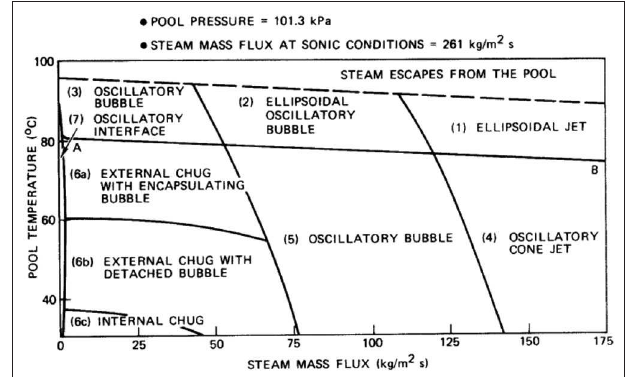
FIGURE 2 | The regime map developed by Chan and Lee